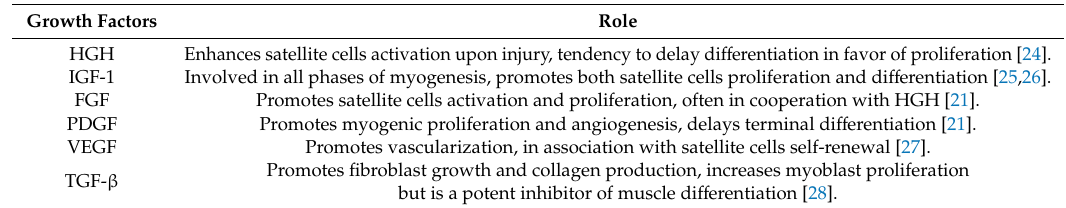
Table 1. Main growth factors involved in myogenesis. HGF: Hepatocyte growth factor; IGF-1: Insulin-like growth factor-1; FGF: Fibroblast growth factor; PDGF: Platelet-derived growth factor; VEGF: Vascular endothelial growth factor; TGF- β : Transforming growth factor